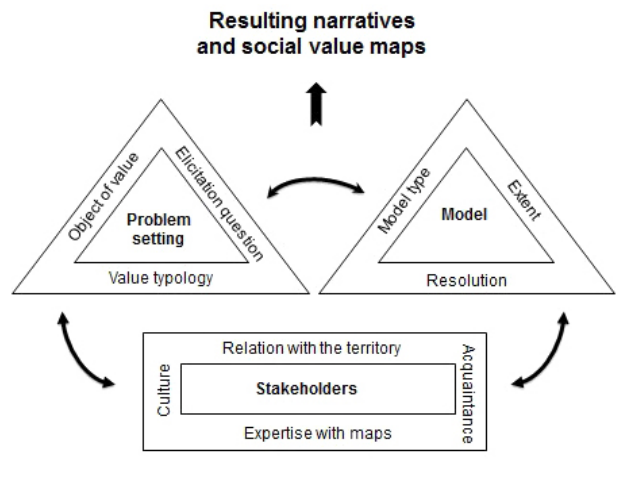
Fig. 5 . Interrelated factors that influence the outcomes from mapping of social value of ecosystem